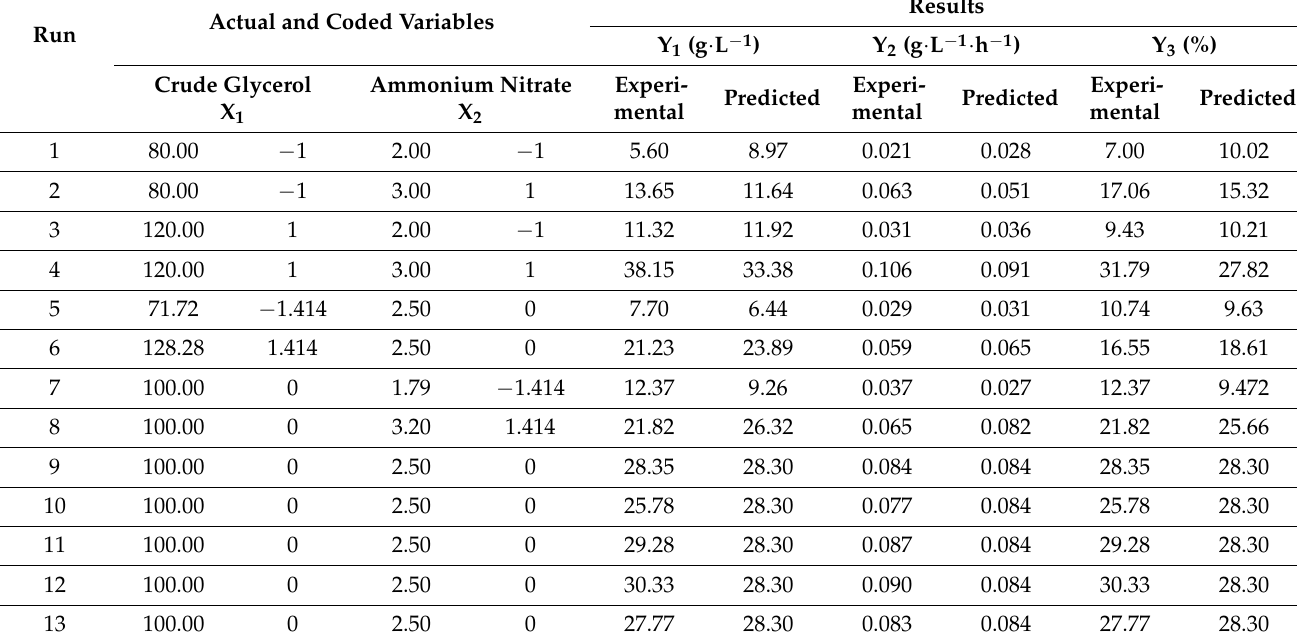
Table 7. Actual and coded variables with the experimental and predicted values.